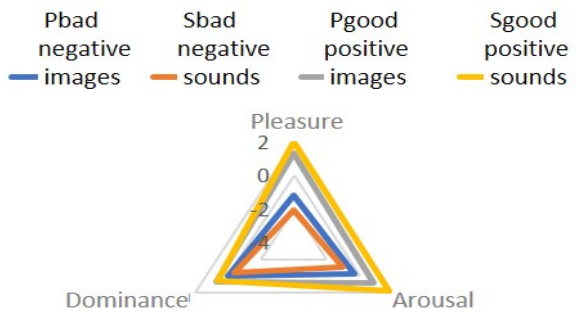
Figure 8. Comparison of the mean valence values of IAPS stimuli for each block-negative video